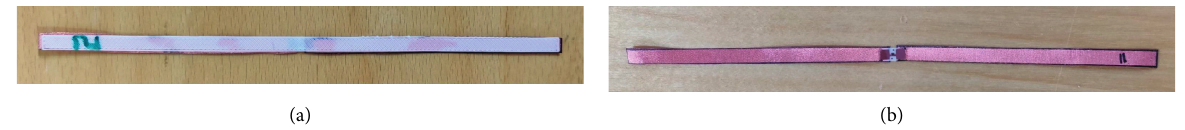
Figure 3: A ready-made bending tag: 3D-printed substrate side (a) and tag antenna side (b). The thickness of the 3D-printed layer is 0.2mm and the thickness of the antenna is